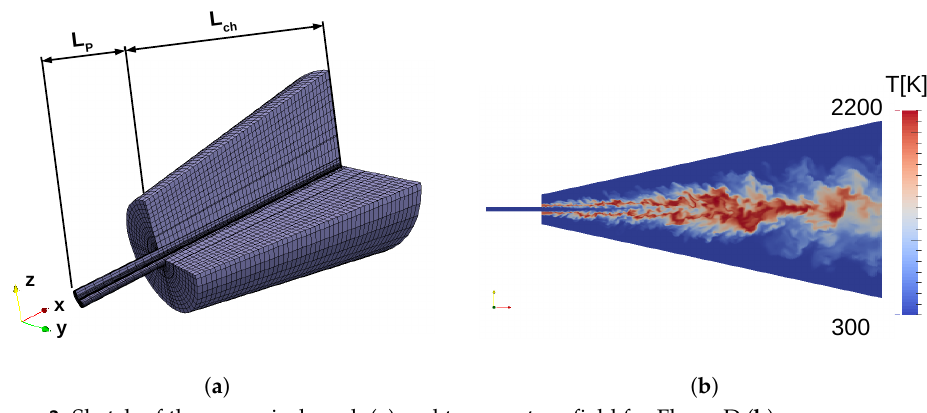
Figure 3. Sketch of the numerical mesh ( a ) and temperature field for Flame D ( b